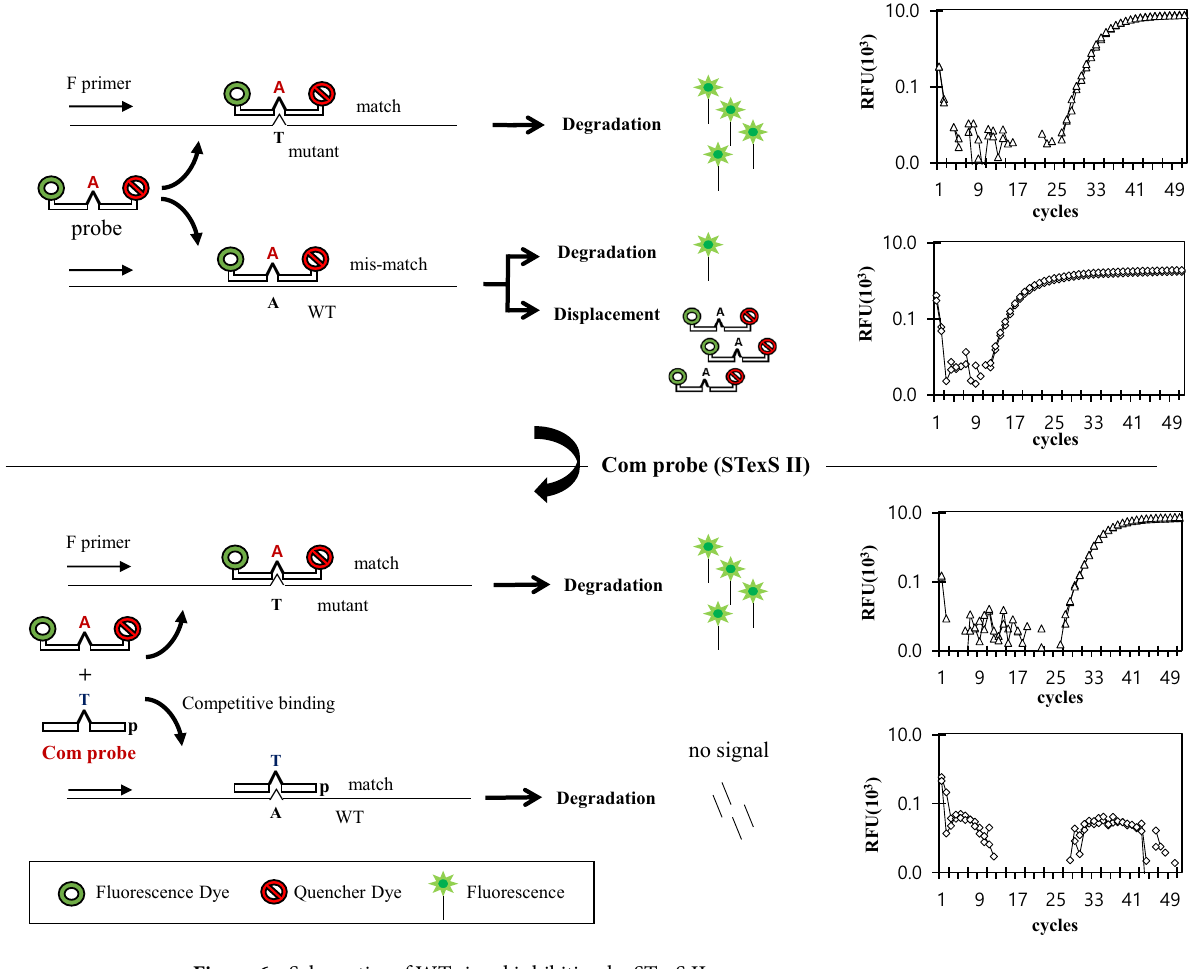
Figure 6. Schematics of WT signal inhibition by STexS